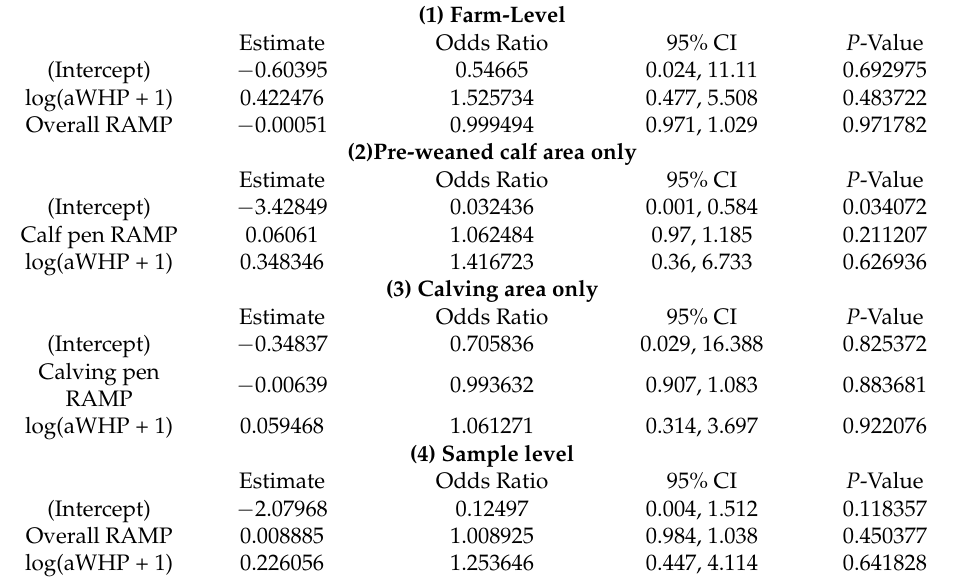
Table 3. Summary of outcomes of logistic regression models with different dependent variables: